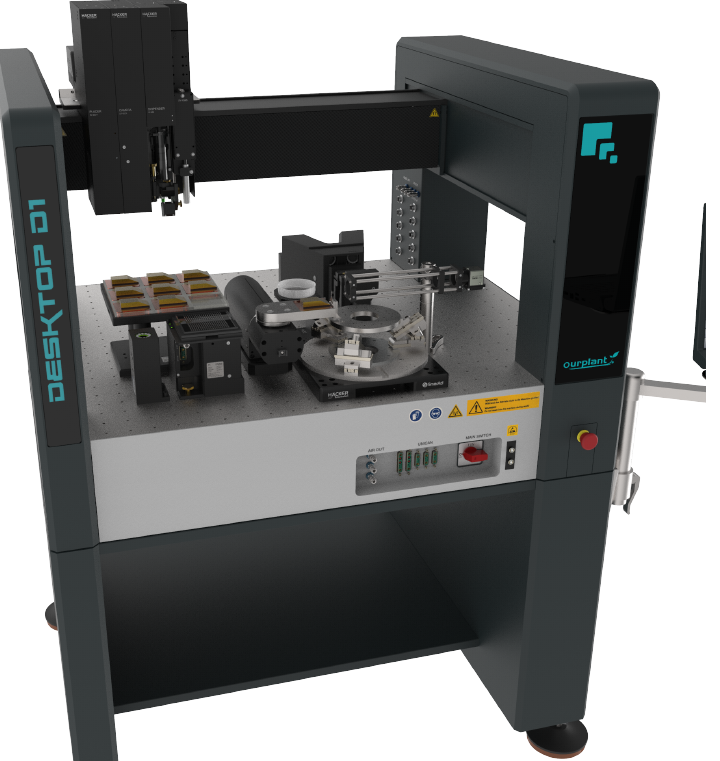
Figure 1. The Desktop D1 from the OurPlant platform of Häcker Automation GmbH (Schwarzhausen, Germany) is a medium-sized reconfigurable manufacturing system (RMS) for micro-assembly purposes. The rendering shows the axis system with the attached processing heads, as well as the base plate with different installed base plate